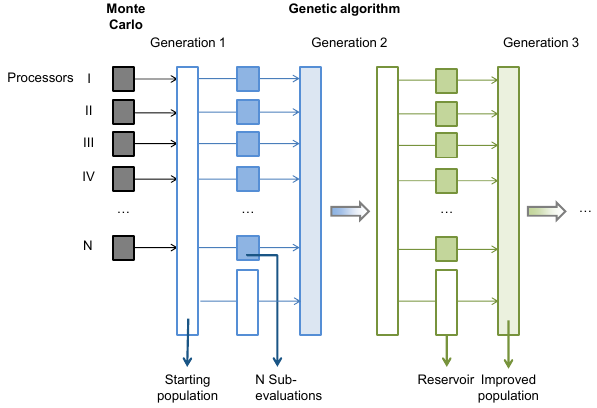
Figure 2. Schematic visualization of the parallelized MCGA opti- mization method. The Monte Carlo step is performed independently on N processors and the best-fitting parameter sets are fed along with random parameter sets into the starting population. During the genetic algorithm step, each processor extracts a number of param- eter sets from the collective pool and performs a sub-evaluation of the genetic algorithm on these parameter sets. After completion, the optimized parameter sets are fed back into the pool, which always contains a non-zero number of parameter sets as a reservoir. Af- ter randomization, a different combination of parameter sets is ex- tracted and the process is